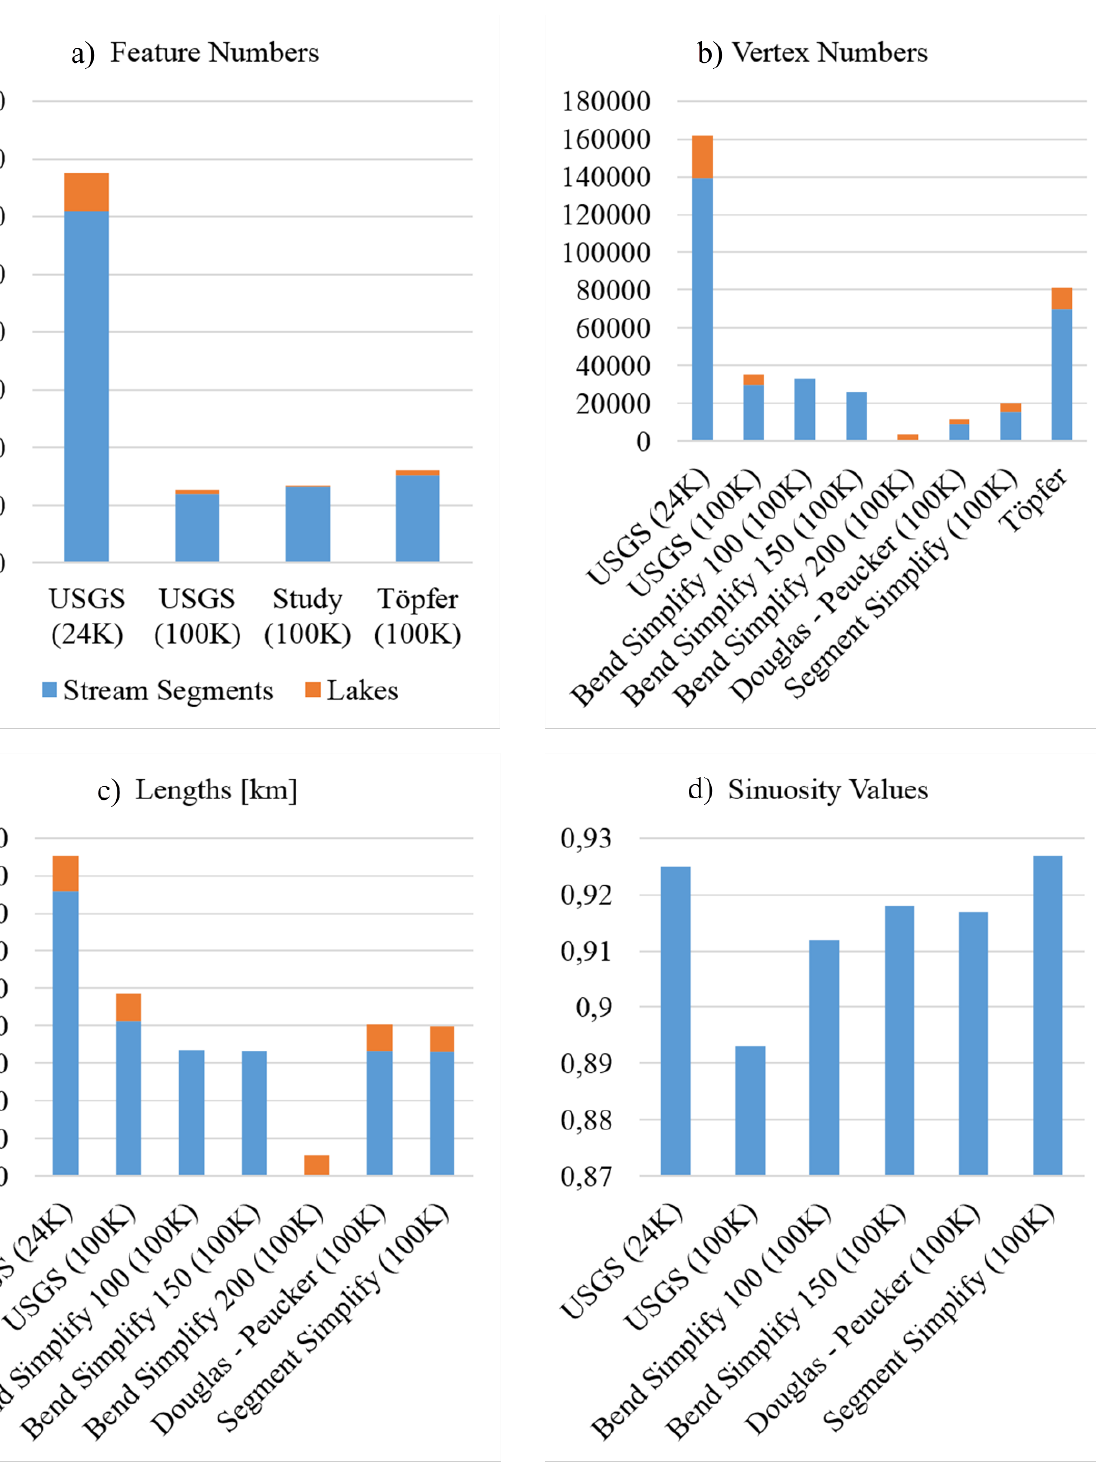
Figure 11. The statistics of the experiment. ( a ) Feature numbers. ( b ) Vertex numbers. ( c ) Lengths (km). ( d ) Sinuosity